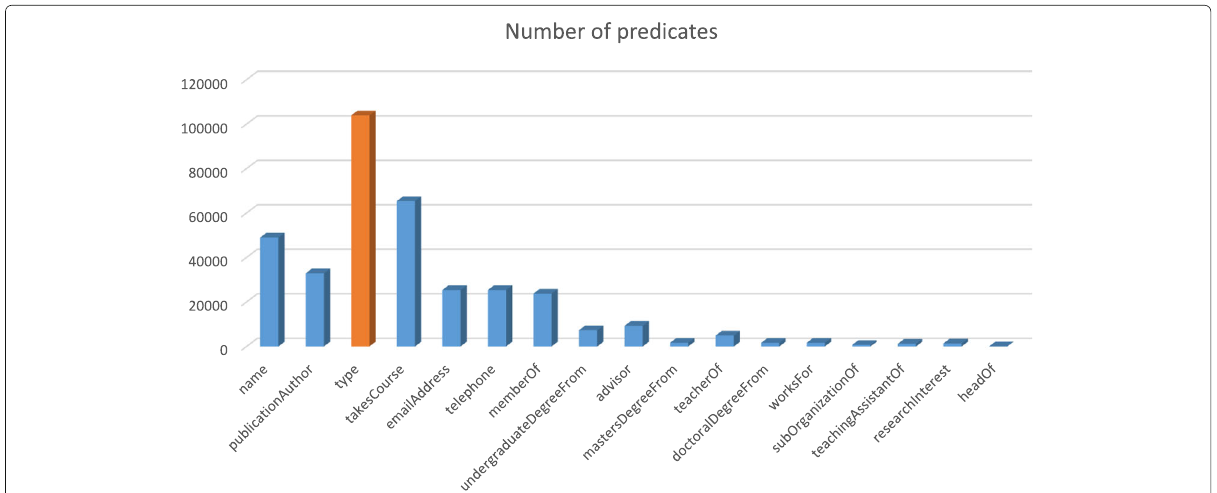
Fig. 5 Sample number of each